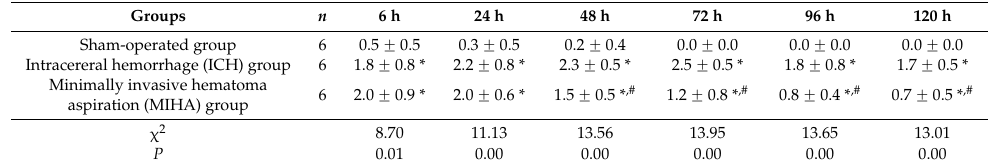
Table 1. The Bederson’s scales in different groups at each time point ( x ˘